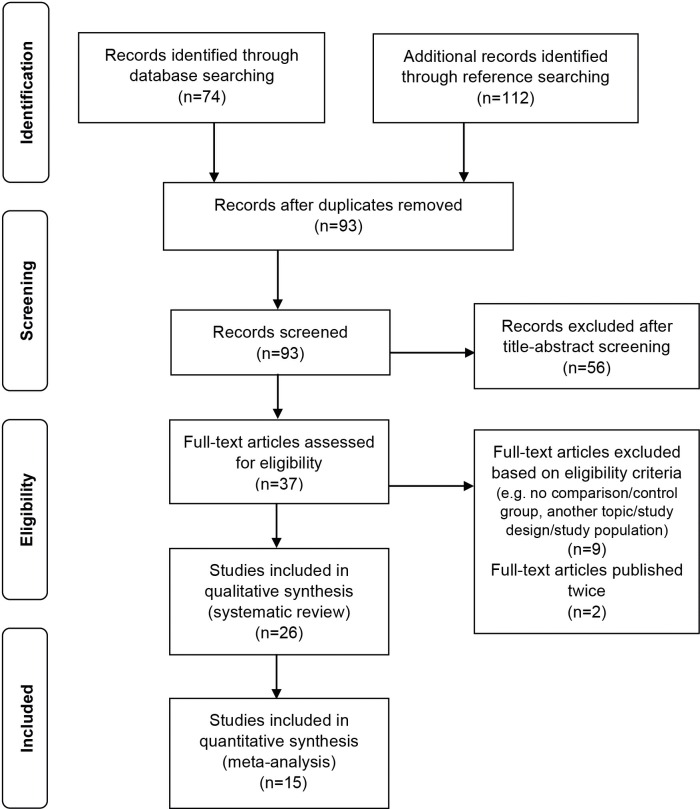
Study selection process for this systematic review (PRISMA flowchart).